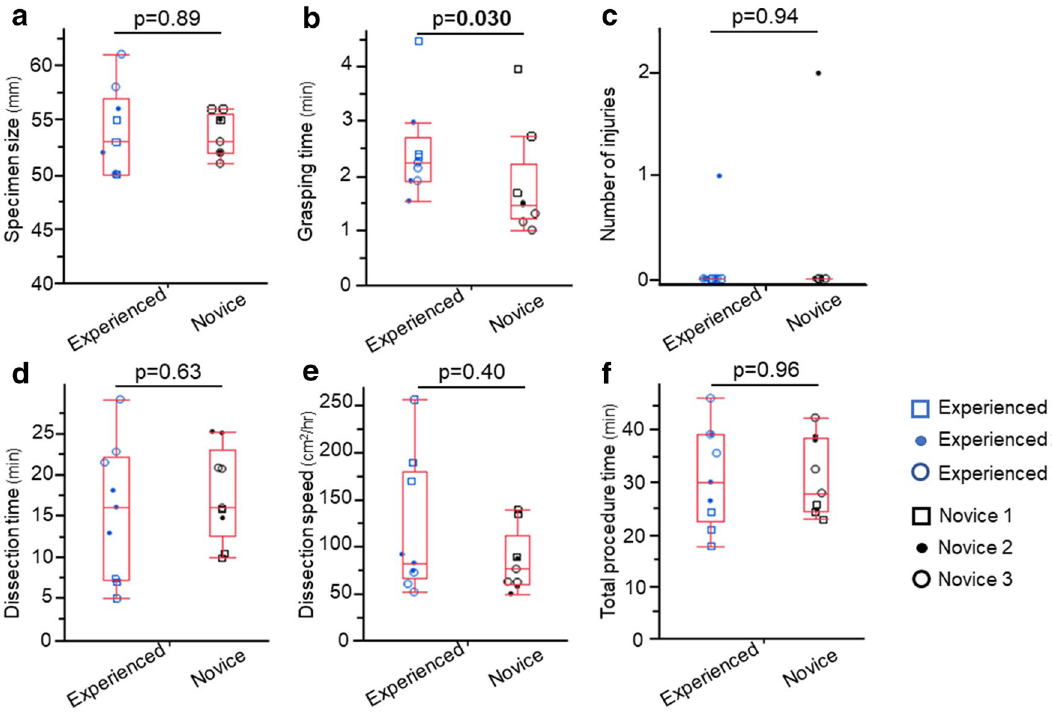
Figure 5. Difference in ESD procedures performed between the experienced and the novice. ( a ) Resected specimen size. ( b ) Grasping time. ( c ) Number of muscularis propria injuries. ( d ) Submucosal dissection time. ( e ) Submucosal dissection speed. ( f ) Total procedure time. Each dot indicates each procedure. The same shape means procedures performed by the same endoscopist (red dot; the experienced, blue dot; the